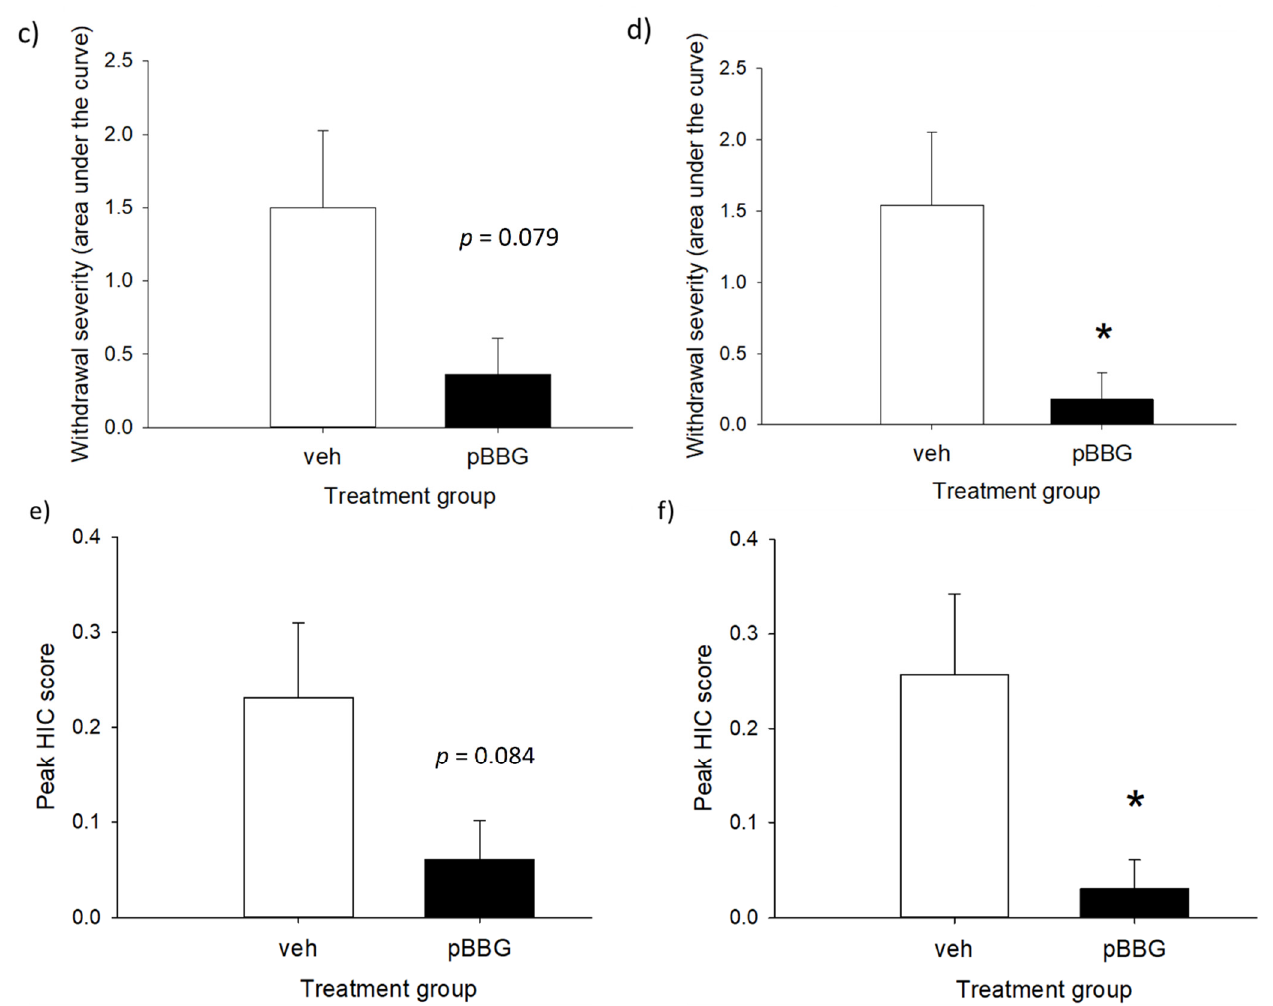
Figure 3. HIC time courses ( a , b ), area under the HIC curve (AUC) from hours 4–10 ( c , d ), and peak HIC scores ( e , f ) after one (left column) and two (right column) withdrawal cycles. Baseline HIC measurements were made before the start of each 10-day ethanol exposure period. Injections of GLO1 inhibitor (pBBG, 25 mg/kg) or the vehicle (veh) were given 3.5 h after the final ethanol injection (indicated by arrows). * indicates a statistically significant difference from the vehicle-treated mice ( p < 0.05). n = 11–13/treatment group.